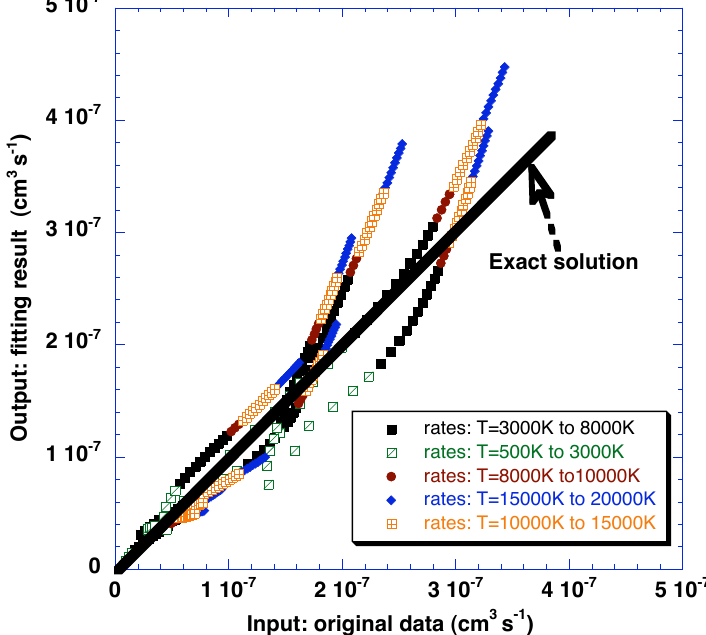
Figure 3. Comparison of the output ( [ C ul ] GP = z ) values to the exact rates ( [ C ul ] experiment ) (called input) calculated directly by averaging the available cross-sections over the kinetic energies. The solid line shows the exact solution and the result of the fit is shown with differently colored squares and circles (as explained in the